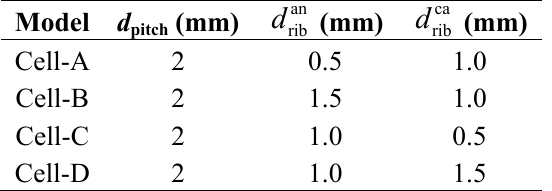
Table 6. Interconnector geometry structure